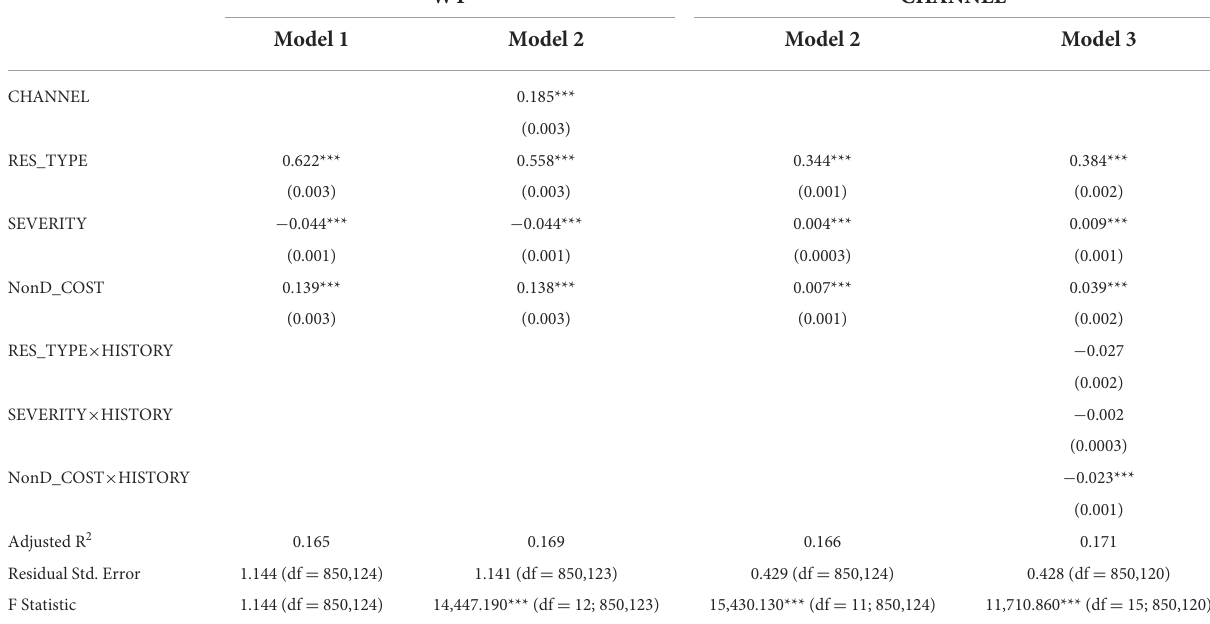
TABLE 8 Robustness check results.